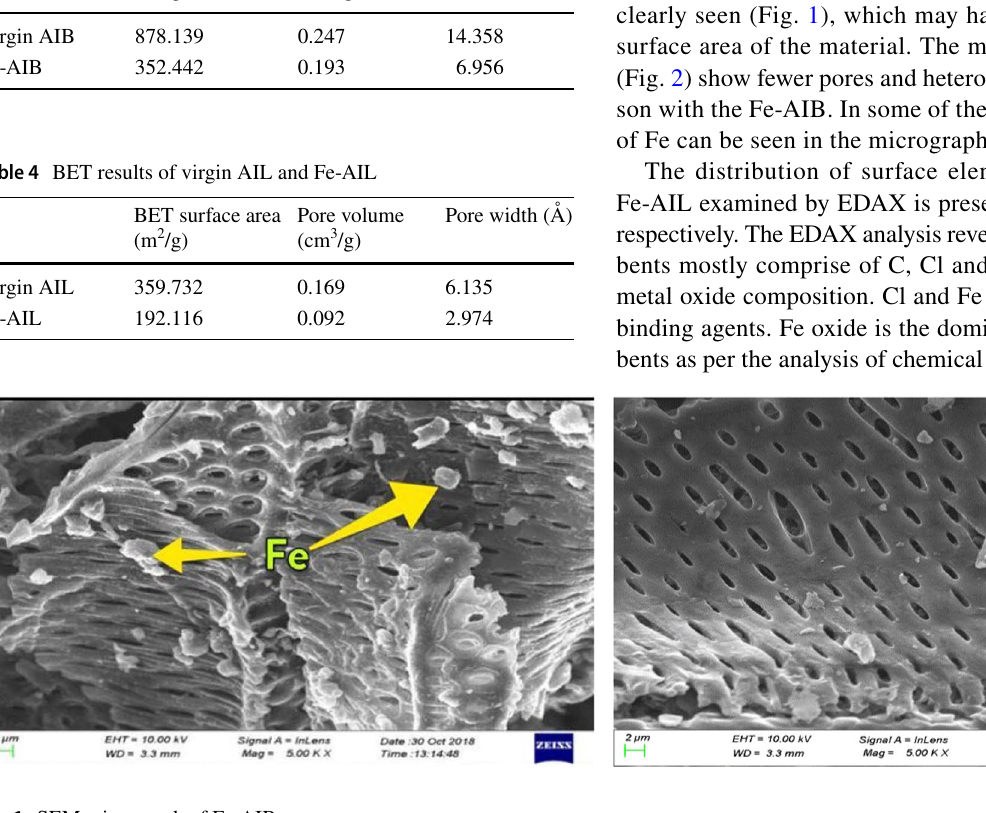
Table 3 BET results of virgin AIB and Fe-AIB BET surface area (m 2 /g)